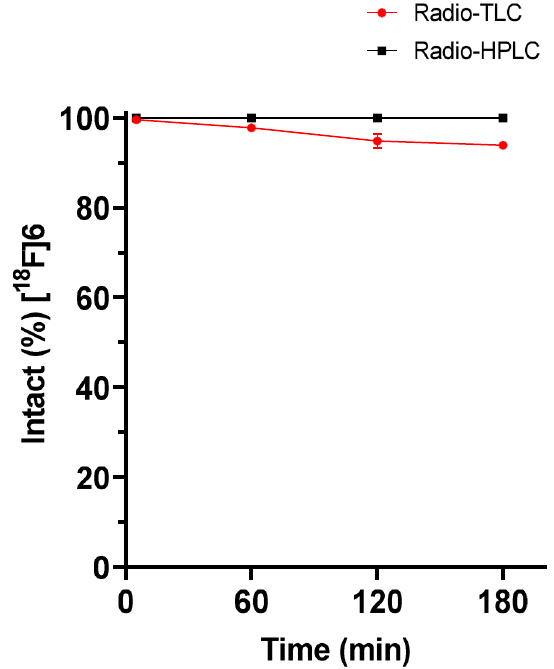
Figure 3. In vitro stability of [ 18 F]SiFA-Tz ([ 18 F] 6 ) after incubation in human plasma at 37 °C, demonstrated excellent stability with ~95% intact tracer at 180 min after start of incubation. The amount of parent [ 18 F] 6 was measured through radio-TLC and radio-HPLC analysis. The Log D pH7.4 of [ 18 F] 6 (1.6 ± 0.2, n = 9) was determined by the shake-flask method, as previously